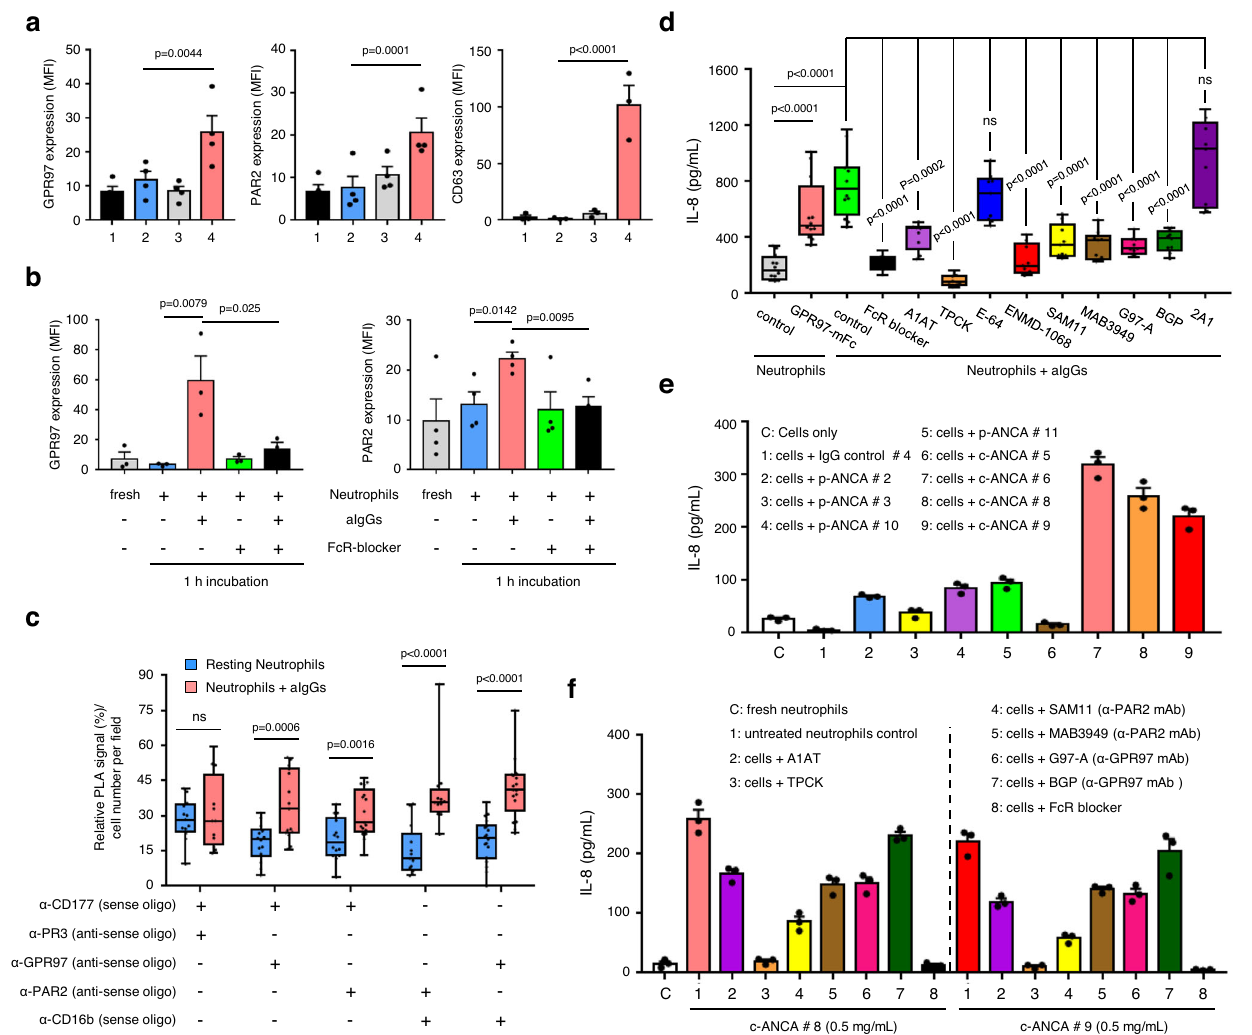
Fig. 6 | Up-regulated GPR97 and PAR2 expression in activated neutrophils inducesGPR97-PAR2activation.a , b FlowcytometryanalysesofGPR97andPAR2 expression in resting neutrophils treated without or with the azurophil granule degranulationstimulants( n =4,exceptCD63 n =3) a andaIgGs(GPR97 n =3,PAR2 n =4) b as indicated. a Samples include: 1, fresh neutrophils; 2, untreated neu- trophils; 3, neutrophils treated with fMLF (1 μ M) for 15min; 4, neutrophils treated with cytochalasin B (cytoB, 5 μ M) for 5min, followed by fMLF (1 μ M) for 10min. CD63 expression was used as a degranulation marker of azurophil granule. c Relative PLAsignalsofindicated receptorpairsin resting( n =3)and aIgG-treated